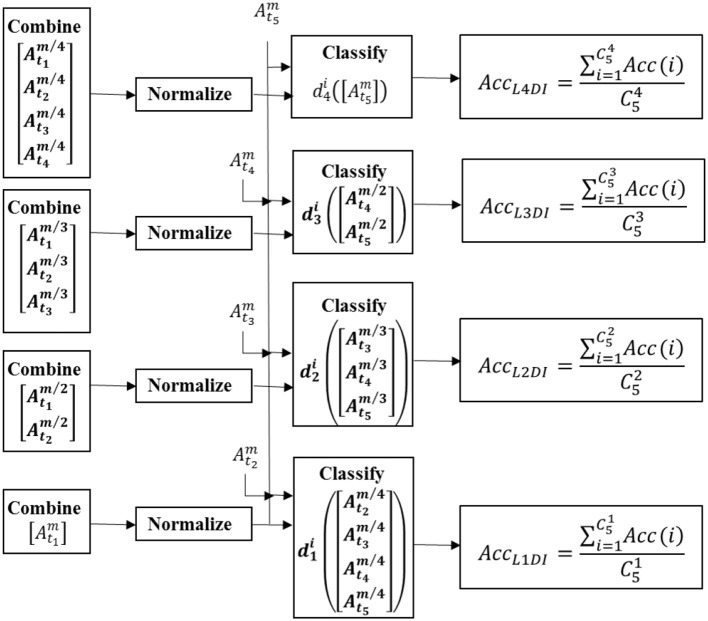
The flow charts of LNDI.